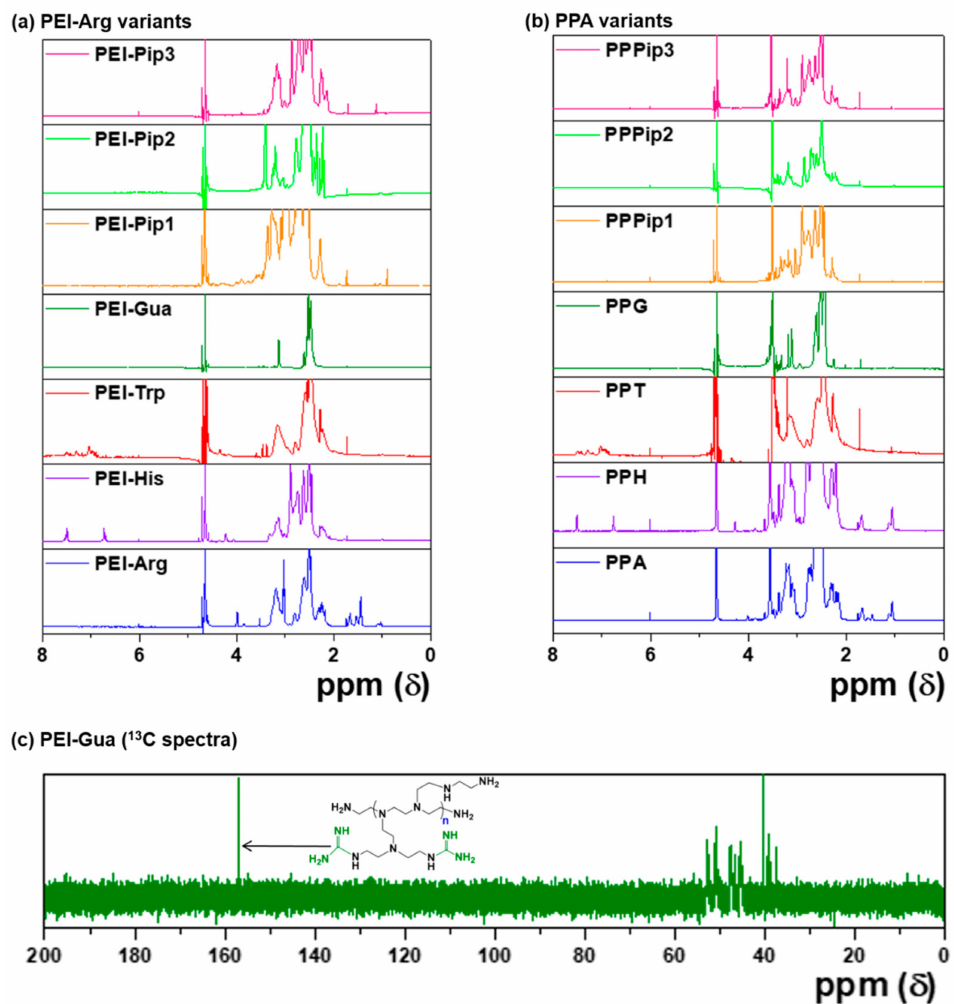
Figure 2. 1 H NMR spectra of ( a ) PEI-Arg variants and ( b ) PPA variants. ( c ) 13 C NMR spectra of PEI-Gua